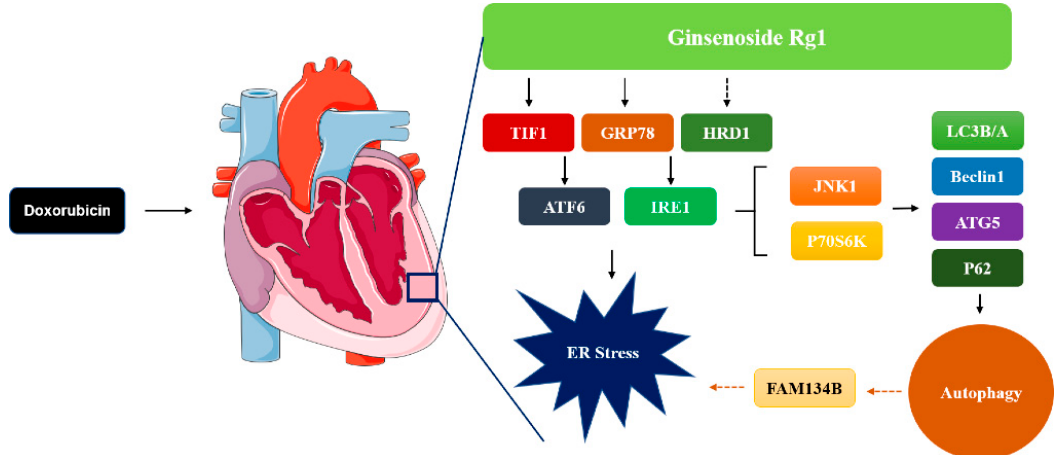
Figure 7. Schematic diagram of how ginsenoside Rg1 attenuates doxorubicin-induced cardiomyotoxicity through the inhibition of autophagy and endoplasmic reticulum stress in mice.